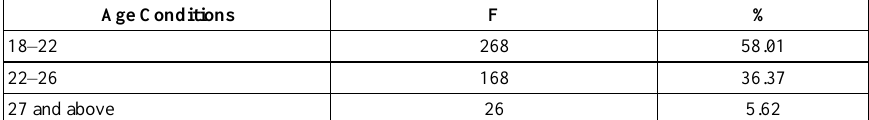
Table 3. Distribution of university students by